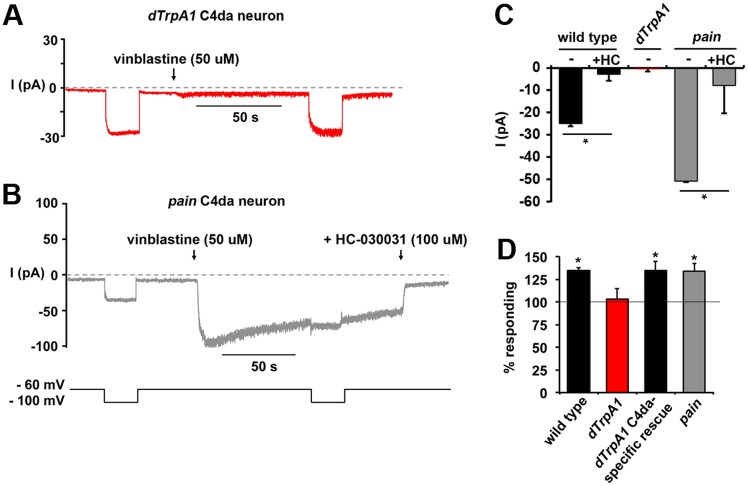
The effects of vinblastine on sensory neurons are absent in dTrpA1 mutants.A and B, Representative traces from voltage-clamped C4da sensory neurons isolated from dTrpA1 (A) or pain (B) mutants held at indicated voltages and challenged with 50 μM vinblastine. C, Graph represents the average values for the currents measured in voltage-clamped C4da sensory neurons from wild type (black bars; data from Fig 4C for comparison), dTrpA1 (red bar), and pain (gray) mutants incubated with 50 uM vinblastine with or without HC-030031 (+HC). * p<0.01 indicate significant difference determined by Student’s T-test. Error bars = SEM, n = 3–6 neurons per condition. D, Behavioral analysis of dTrpA1 (red bars) and pain (gray bars) mutant larvae find that the effects of vinblastine are specifically absent in dTrpA1 mutants and that re-expression of wild type dTrpA1 only in C4da neurons rescues this deficit in dTrpA1 mutants. For these genetic analyses, average values were normalized to the vehicle controls assayed in parallel of the same experimental genotype. Gray line indicates vehicle (100%) values. * p < 0.05 determined by Student’s T-test of drug vs. vehicle for each genotype. Error bars = SEM, n = 160–200 larvae per condition.